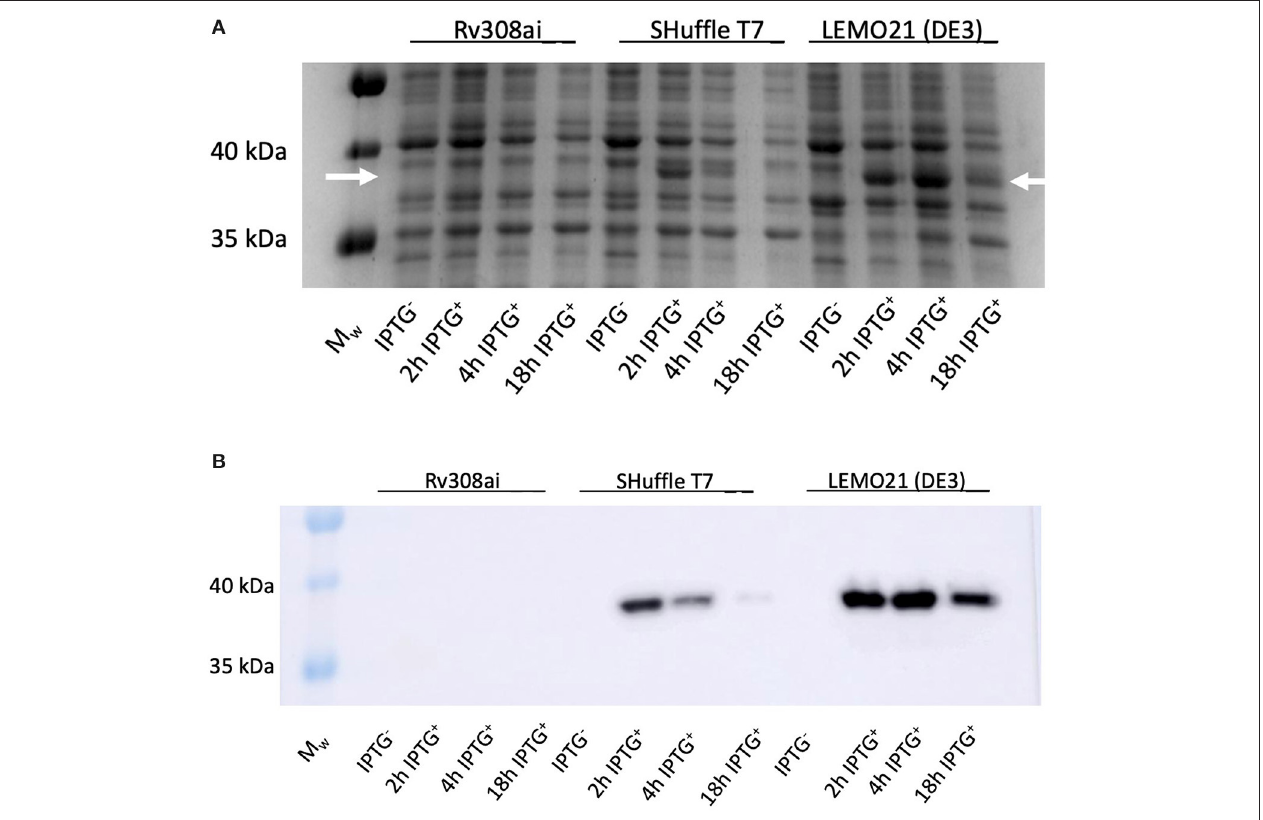
FIGURE 2 | RrADH 50mL expression in E. coli strains Rv308ai, Shuffle T7, LEMO21 (DE3) in TB medium at 37 ◦ C analyzed by SDS-PAGE (A) and Western Blot (B) . M w – molecular weight marker; IPTG − - non-induced expression; 2h IPTG + - 2h after induction; 4h IPTG + - 4h after induction; 18h IPTG + - 18h after induction (arrows indicate the approximate position of RrADH).